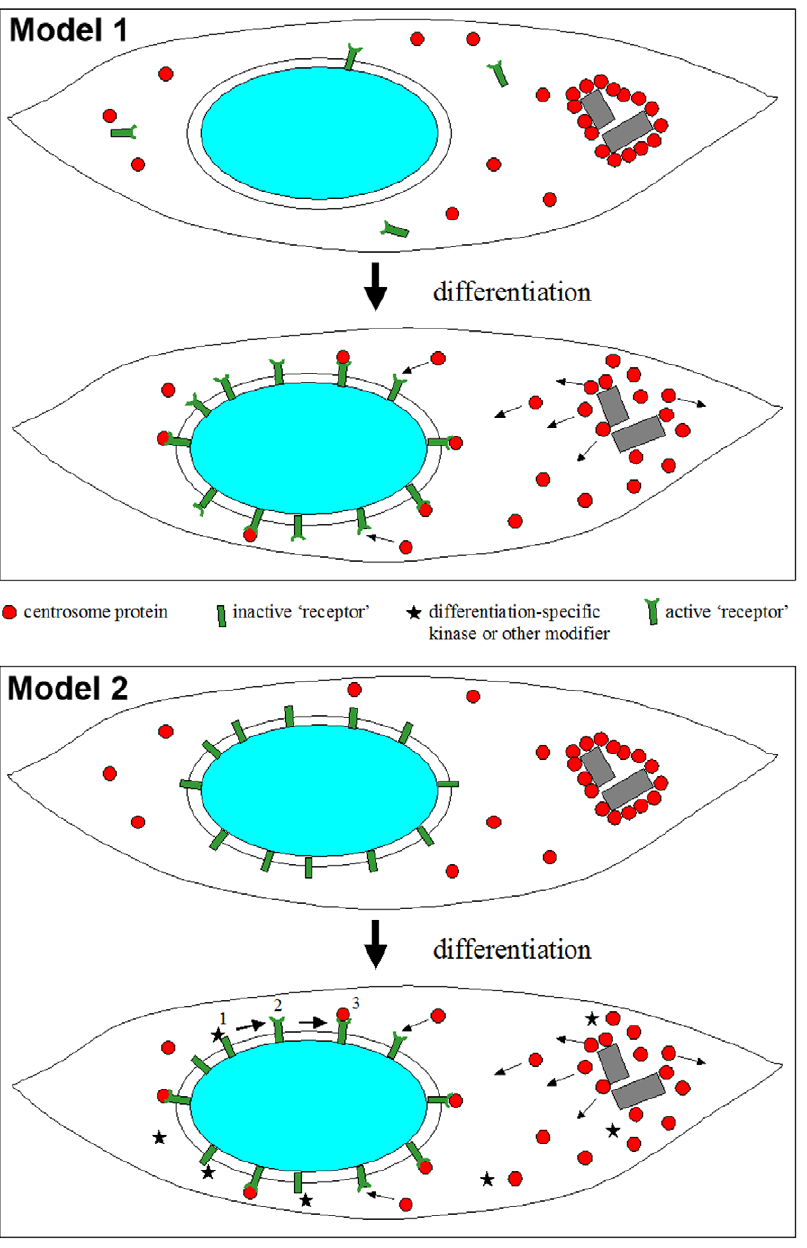
Figure 7. Potential mechanisms of centrosome protein relocalization in differentiating muscle cells. Model 1: during differentiation of myoblasts, ‘receptor’ proteins (green) are expressed that bind to the nuclear surface and that recruit centrosome proteins (red). Centrosome proteins that are found enriched at the pericentriolar material prior to differentiation are transferred to the nuclear surface via dynamic exchange through a soluble cytoplasmic pool. Because the sequestration of centrosome proteins to the nuclear surface lowers the concentration of the soluble cytoplasmic pool, and because this pool is in an equilibrium with centrosome proteins at the pericentriolar material, sequestration to the nucleus will indirectly lead to the disassembly of the pericentriolar material (small arrows), and finally to the loss of centrosomal activity. Model 2: in undifferentiated myoblasts (top), nuclei possess putative ‘receptor’ proteins (green) at their outer surface that become activated only at the onset of differentiation (bottom). (1) This activation may be mediated by specific kinases, or by other factors involved in posttranslational modification (stars). (2) As a consequence, the receptors are now competent to bind centrosome proteins to the nuclear surface (3). doi:10.1371/journal.pone.0008303.g007 myotubes. After removal of the culture medium, cells were treated fetal calf serum and 20 I.U. interferon-gamma [10]. Differentia- with 1x Trypsin/EDTA (Gibco) for several seconds, leading to tion of H-2K b -tsA58 cells was induced by temperature shift to selective detachment of myotubes. Detachment was monitored by 37 u C and simultaneous serum starvation, by replacing the regular phase contrast microscopy. Detached cells were collected and growth medium with Dulbecco’s modified Eagle’s medium trypsin was neutralized by addition of growth medium. Cells were containing only 2% fetal calf serum. H-2K b -tsA58 cells were differentiated for five days, to obtain a high yield of differentiated then seeded with exponentially growing U2OS cells. The following